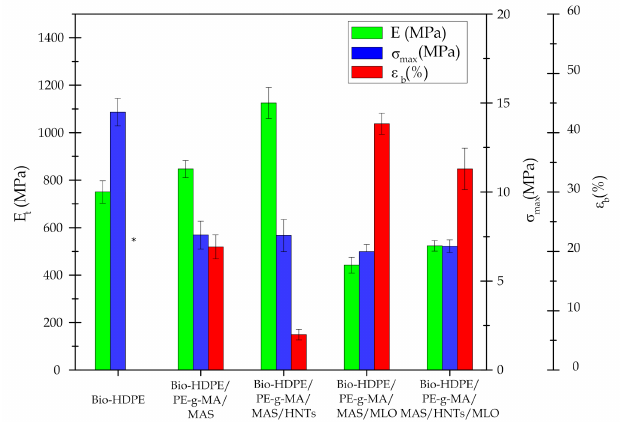
Figure 2. Mechanical properties of the injection-molded samples of Bio-HDPE blends. Tensile modulus (E), maximum tensile strength ( σ max ) elongation at break ( ε b ). * Elongation at break for the Bio-HDPE could not be assessed because breakage is not